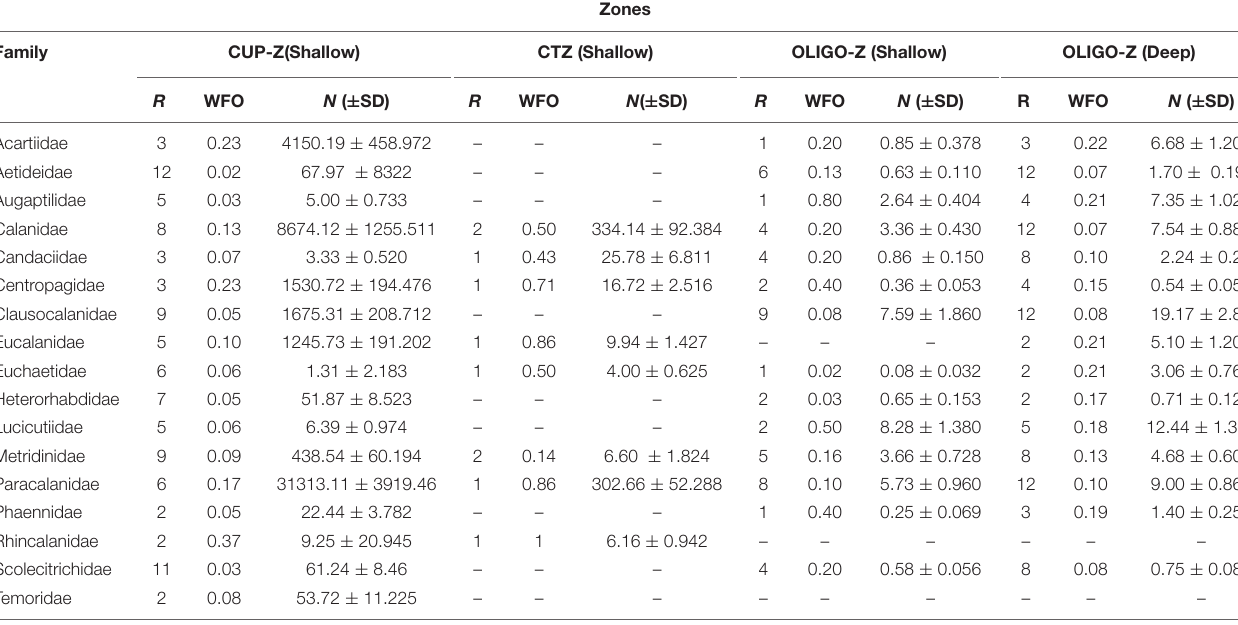
TABLE 1 | Community descriptors for copepod families of the order Calanoida in the southeast Pacific during 2002 to 2015.